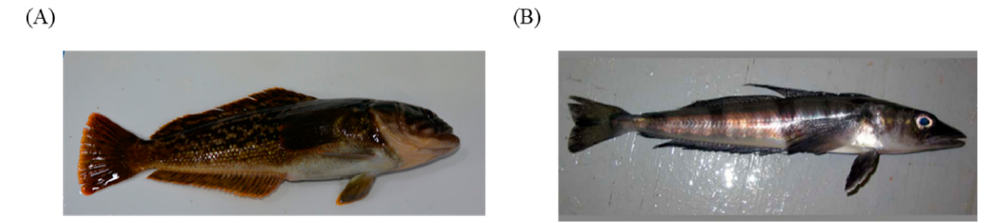
Figure 1. Experimental fish: ( A ) Notothenia rossii ; ( B ) Champsocephalus gunnari .